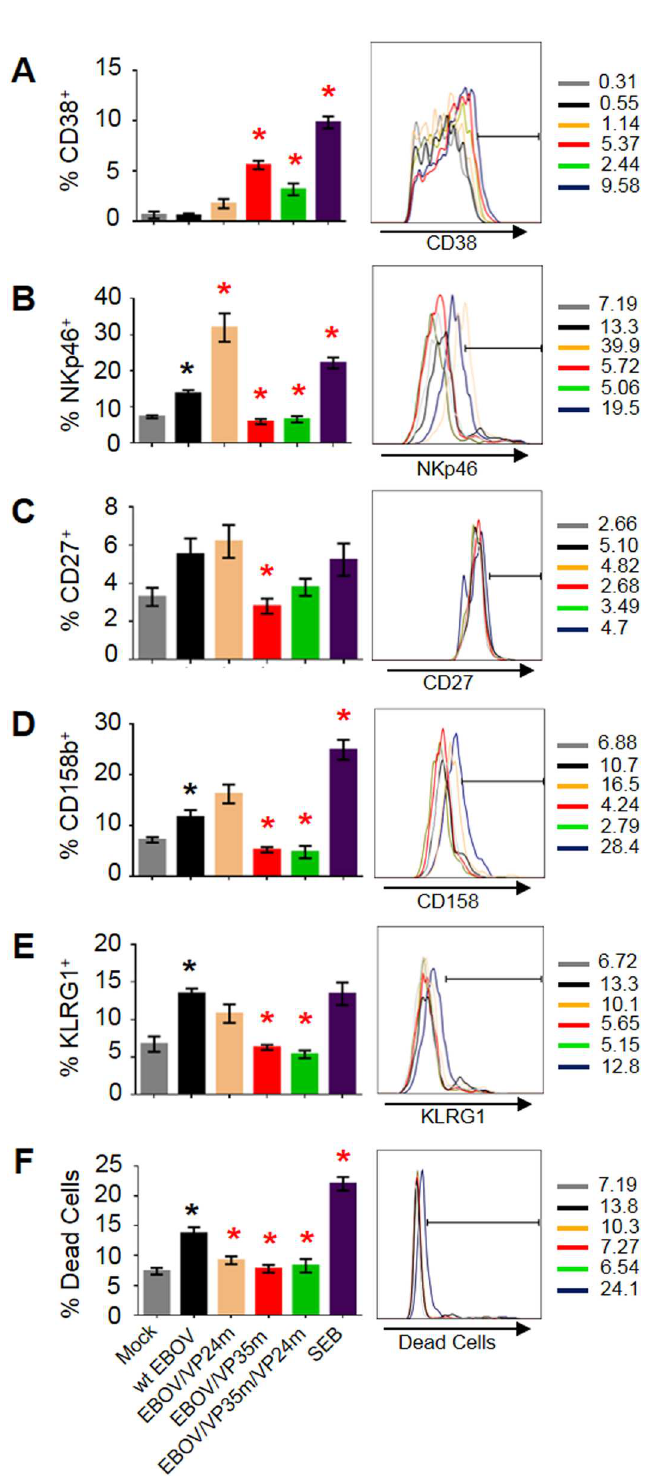
Fig 10. VP35 and VP24 IID suppress activation of NK cells. PBMCs were infected with wt EBOV or the mutated viruses, and gated CD56 + CD3 - NK cells were analyzedfor the indicatedmarkers of activation, inhibitionor dead cell markers: A , CD38; B , NKp46; C , CD27; D , CD158b; E KLRG1; F , Live/Dead.Mean values based on 3 donors with SE are shown. Statistically significantdifferences(P < 0.05)for wt EBOV as comparedto mock are indicatedwith black asterisks, and for the mutated viruses as comparedto wt EBOV are indicatedwith red asterisks. Percentagesof cell populationsare indicatednext to each